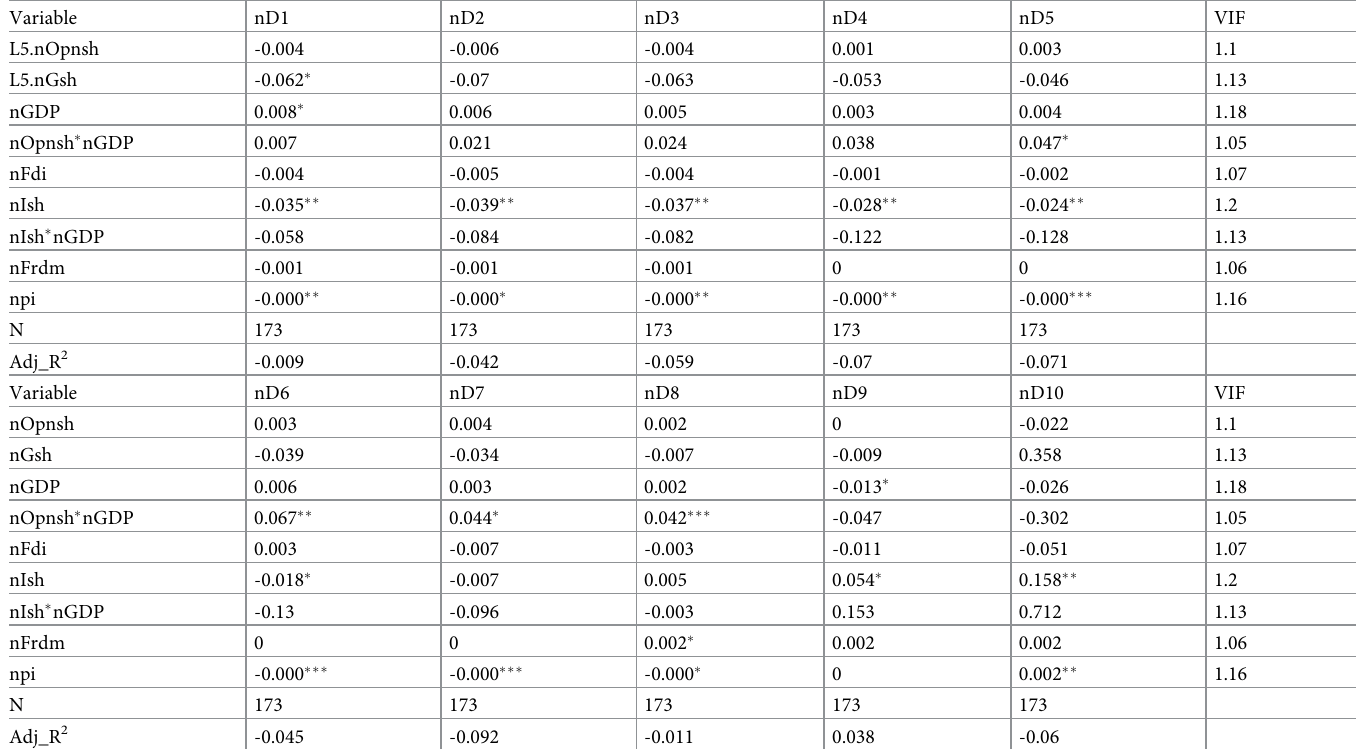
Table 11. Replication of Milanovic (2005) with the quasi-cross-sectional data.